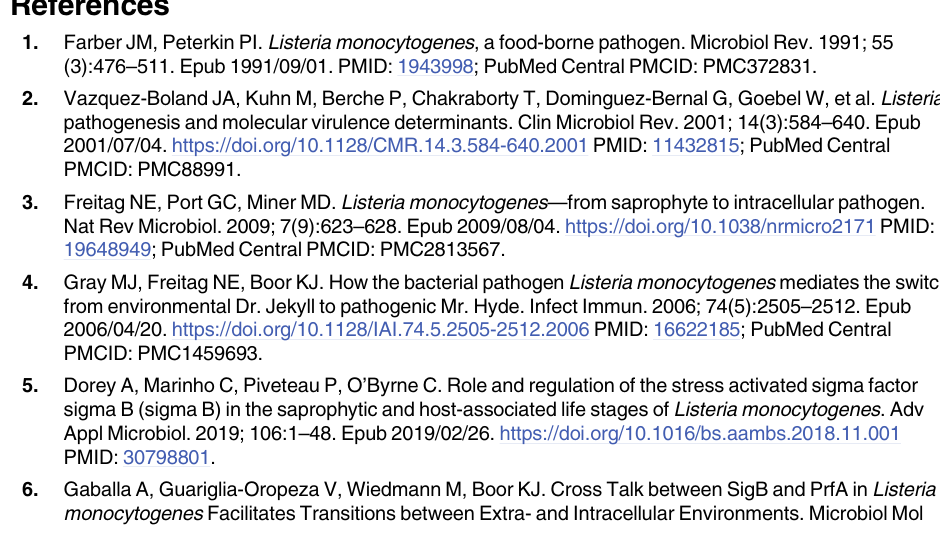
relative to the normalized fluorescence level of L . monocytogenes cells expressing the reporter fusion and growing in untreated BHI. Statistical analysis was done using the GFP/OD from at least 6 independent biological replicates; error bars represent SEM. Asterisks denote significant difference between the normalized fluorescence level at the given condition com- pared to normalized fluorescence level in AC-BHI ( p- value � 0.05,) as determined by one-way ANOVA and Dunnett’s post hoc test. S2 Fig. Expression of P -eGFP in the presence of iron, zinc or both. L . monocytogenes hly strain expressing a P -eGFP reporter fusion was grown in BHI supplemented with different hly concentrations of iron, zinc, or both. GFP fluorescence levels were normalized by culture OD . Fold change of expression (for graphing purpose) was calculated as a ratio of normal- 600 ized GFP fluorescence level relative to the normalized fluorescence level of L . monocytogenes cells expressing the reporter fusion and growing in untreated BHI. Data represent the mean of at least 3 independent biological replicates; error bars represent SEM.